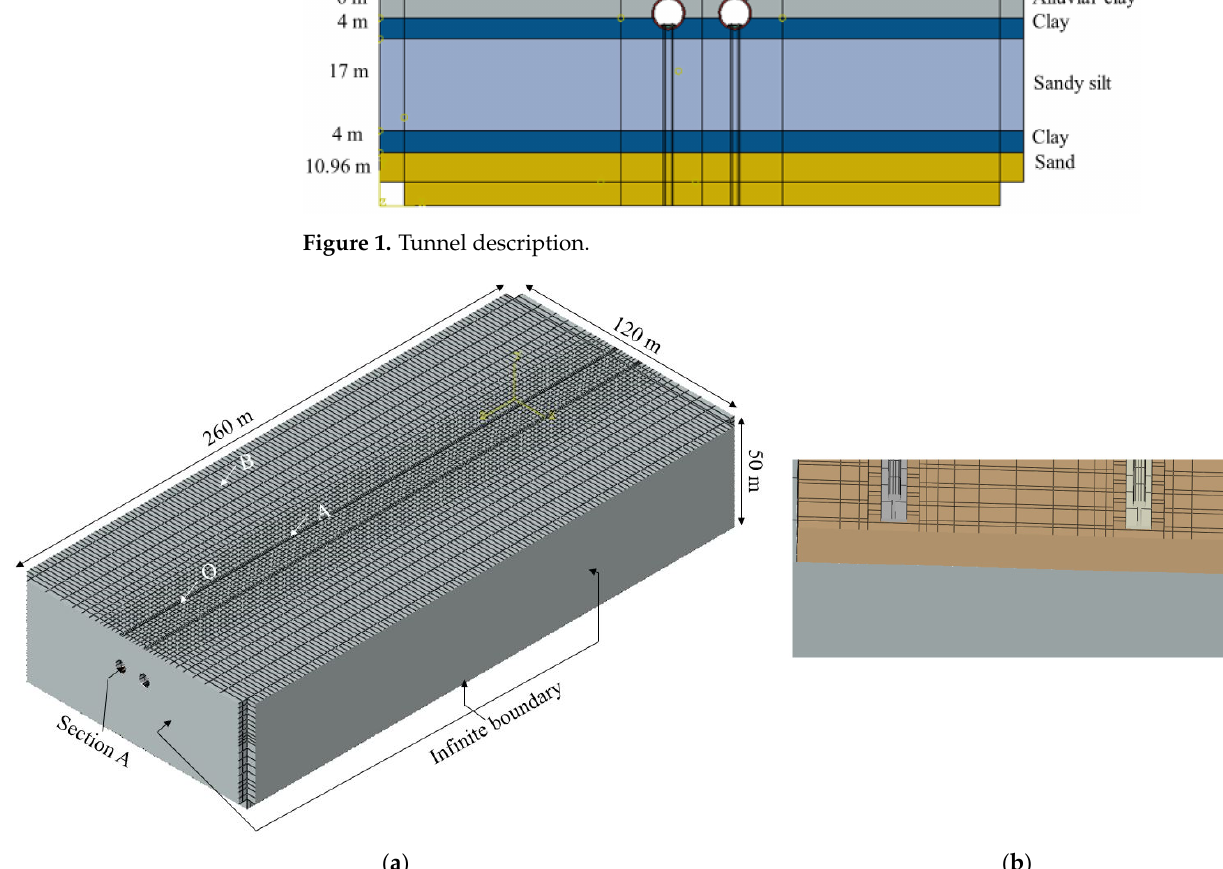
Figure 2. Model 3D mesh. ( a ) Mesh and boundary conditions view; ( b ) section A.